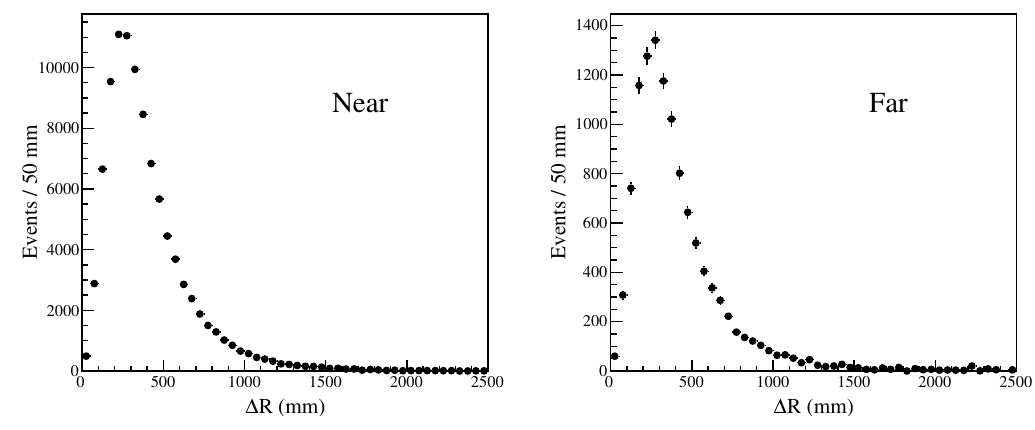
Figure 17 . (cid:1) R distribution of IBD candidates with almost no accidental